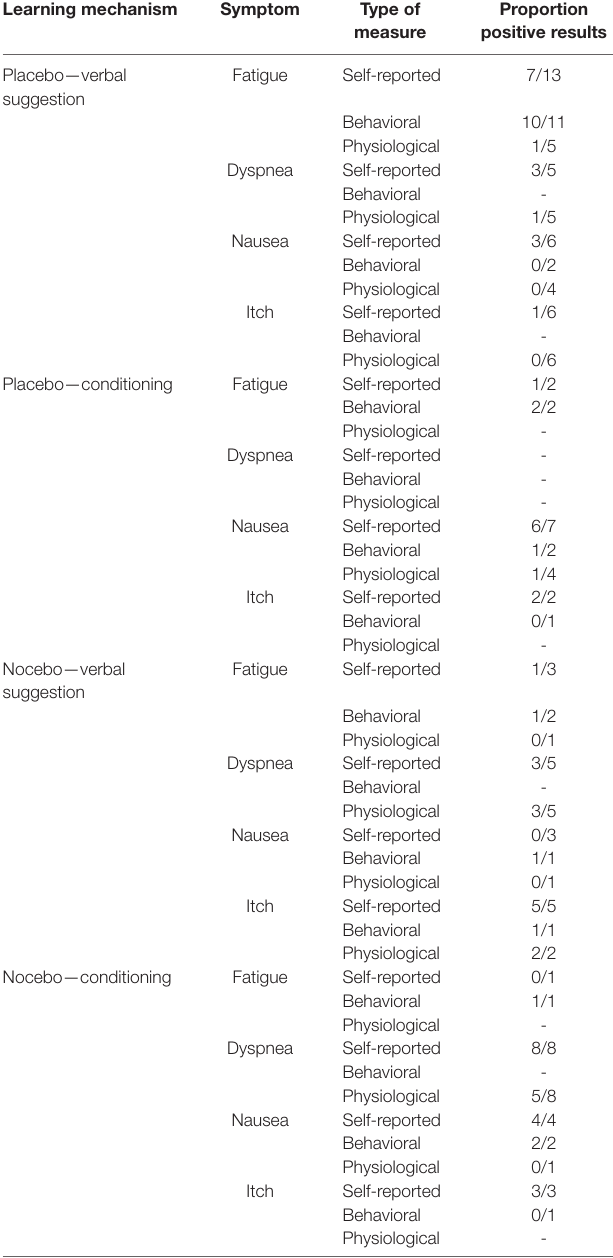
TABLE 1 | Overview of results of included studies. Learning